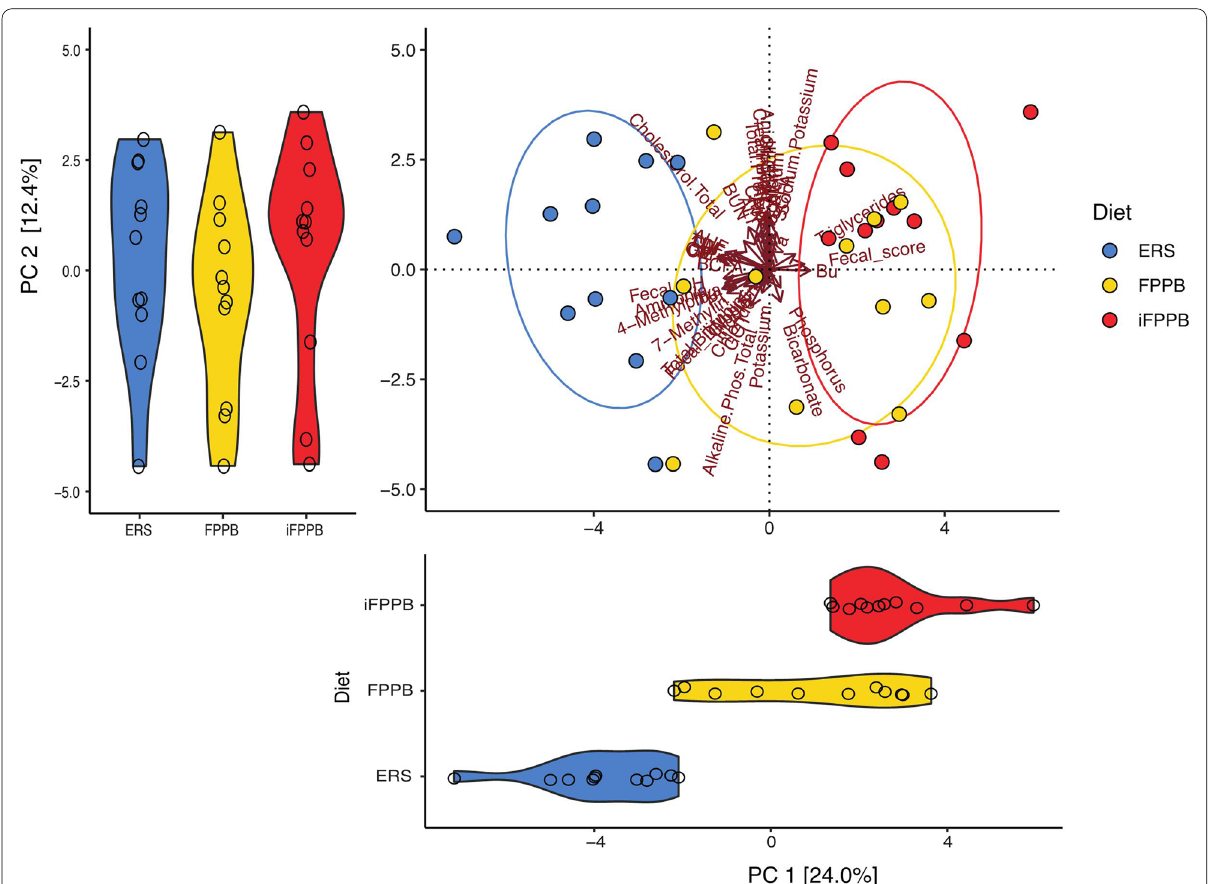
Fig. 5 Principal component analysis of fecal and blood sample data from cats fed the experimental diets. The data show that serum triglyceride concentrations, fecal butyrate concentrations, and fecal scores were the primary variables driving principal component 1 in cats fed FPPB and iFPPB and fecal pH and fecal ammonia concentrations were the primary variables driving principal component 1 in cats fed ERS. Each dot represents a single cat eating one of the experimental